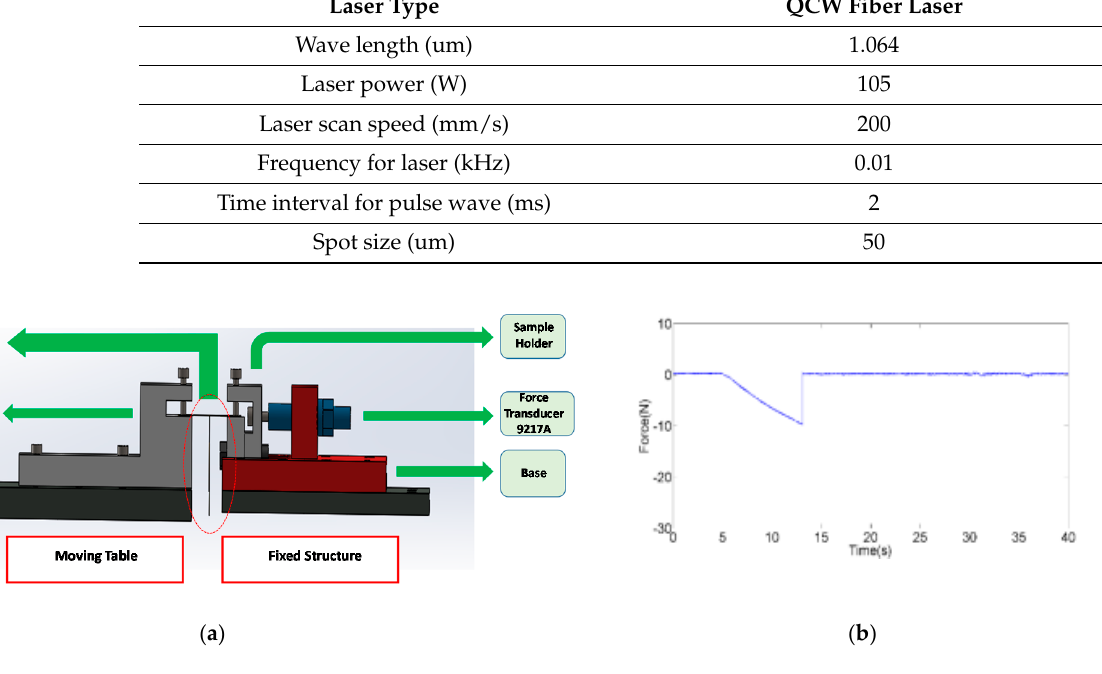
Figure 2. Peeling test ( a ) equipment and ( b ) recorded force